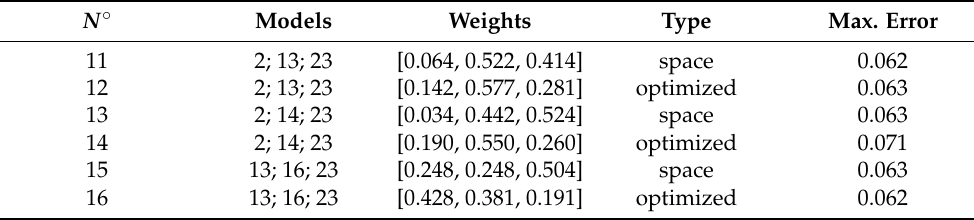
Table 11. Ensemble models tested using three single models and the maximum error obtained.